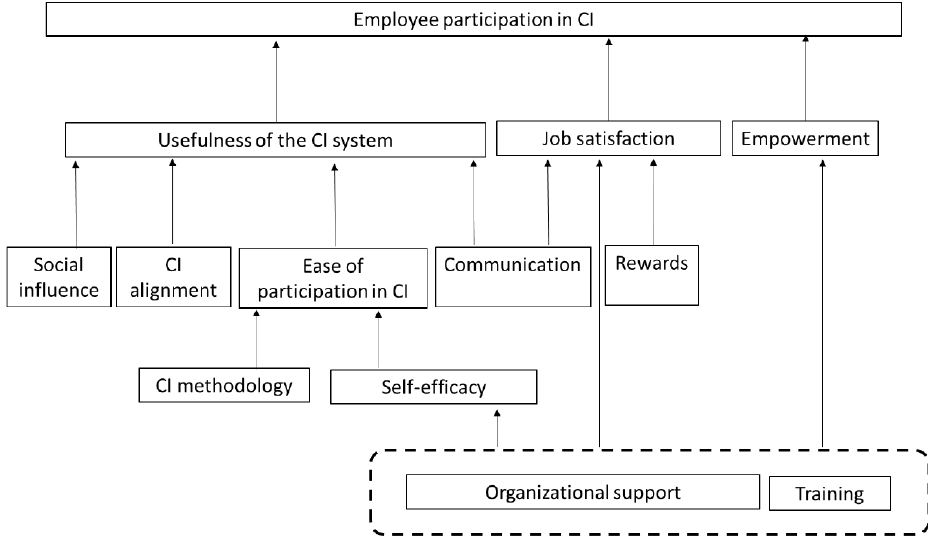
Figure 1. Comprehensive model for EP and its main determinants (Jurburg et al.,